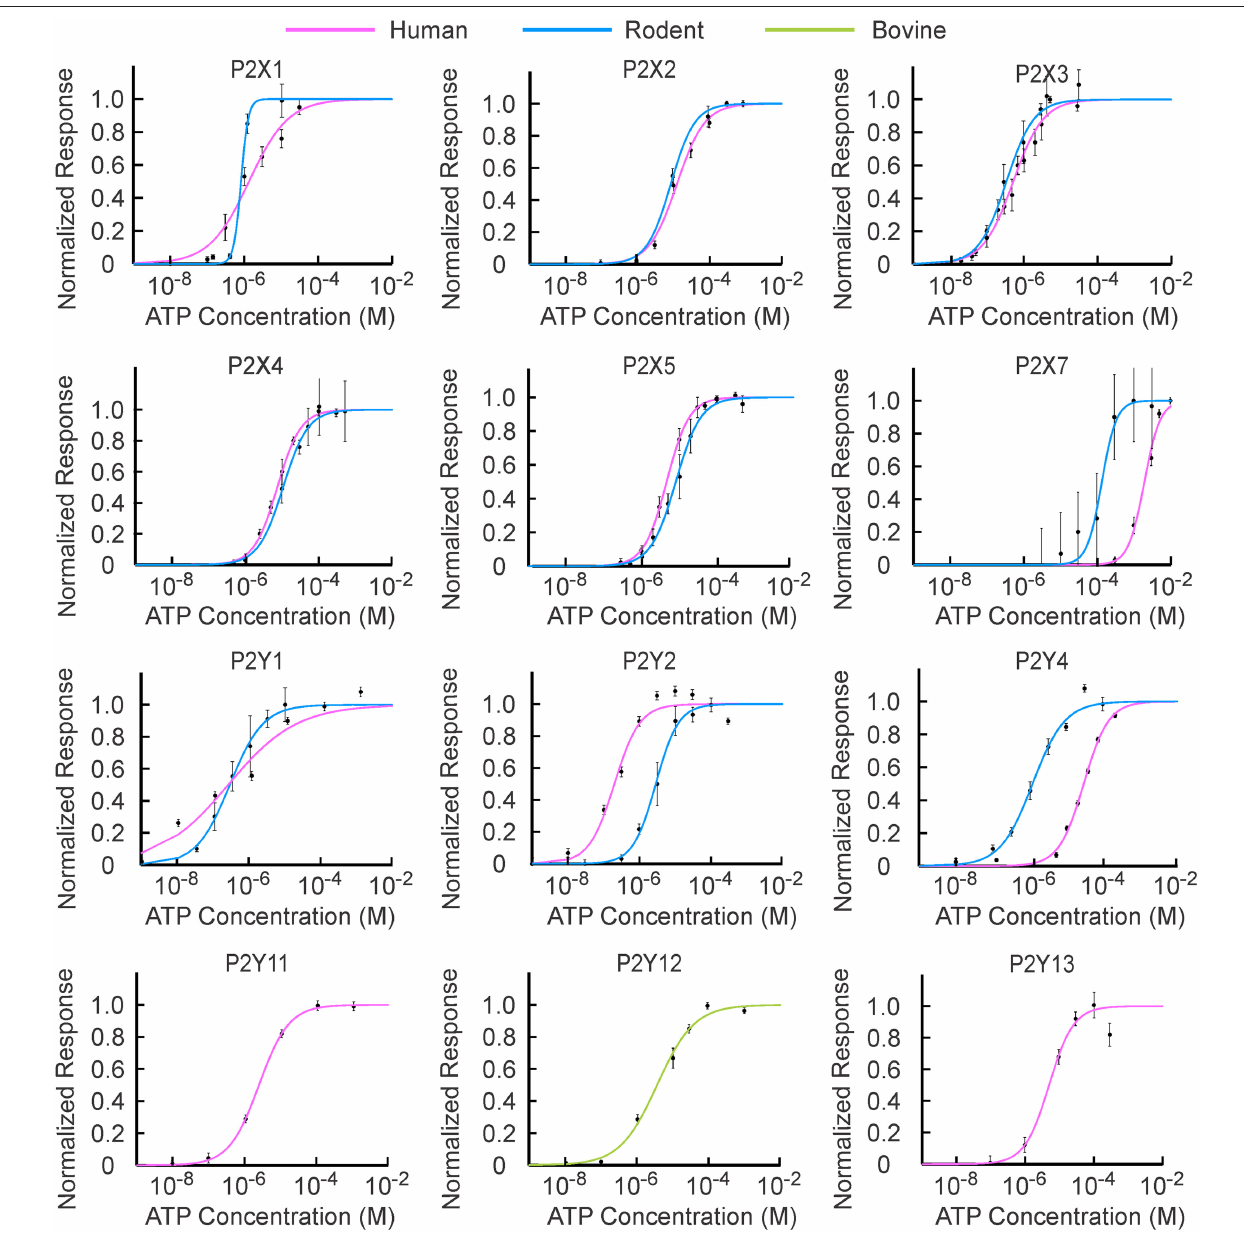
FIGURE 1 | [ATP] sensitivity of P2X and P2Y receptor families. The experimental data points for human and rodent P2 receptors denoted by dots were re-plotted from papers indicated in Tables 1 , 2 . P2Y11 transcripts have not been found in rodents; therefore, only human P2Y11 was used. The experimental data for [ATP] dependence of human and rodent P2Y12 and rodent P2Y13 were not found in the literature, therefore bovine P2Y12 and human P2Y13 were used. The data were normalized to the maximal response. [ATP] dependence for each receptor was fit with the Hill equation with R 2 > 0.95, and shown in pink for human, blue for rodent, and green for bovine